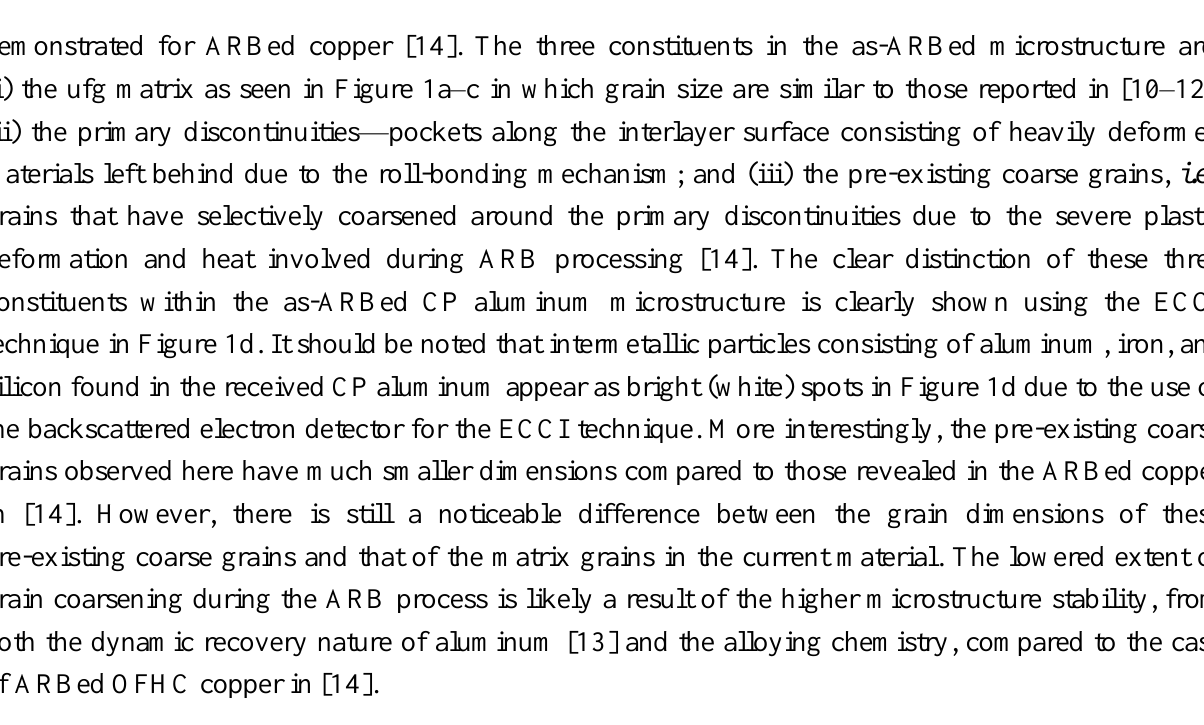
Figure 1. Microstructure of the ( a ) 4p; ( b ) 6p; and ( c ) 8p Accumulative Roll Bonding (ARB) CP aluminum samples as viewed under bright field transmission